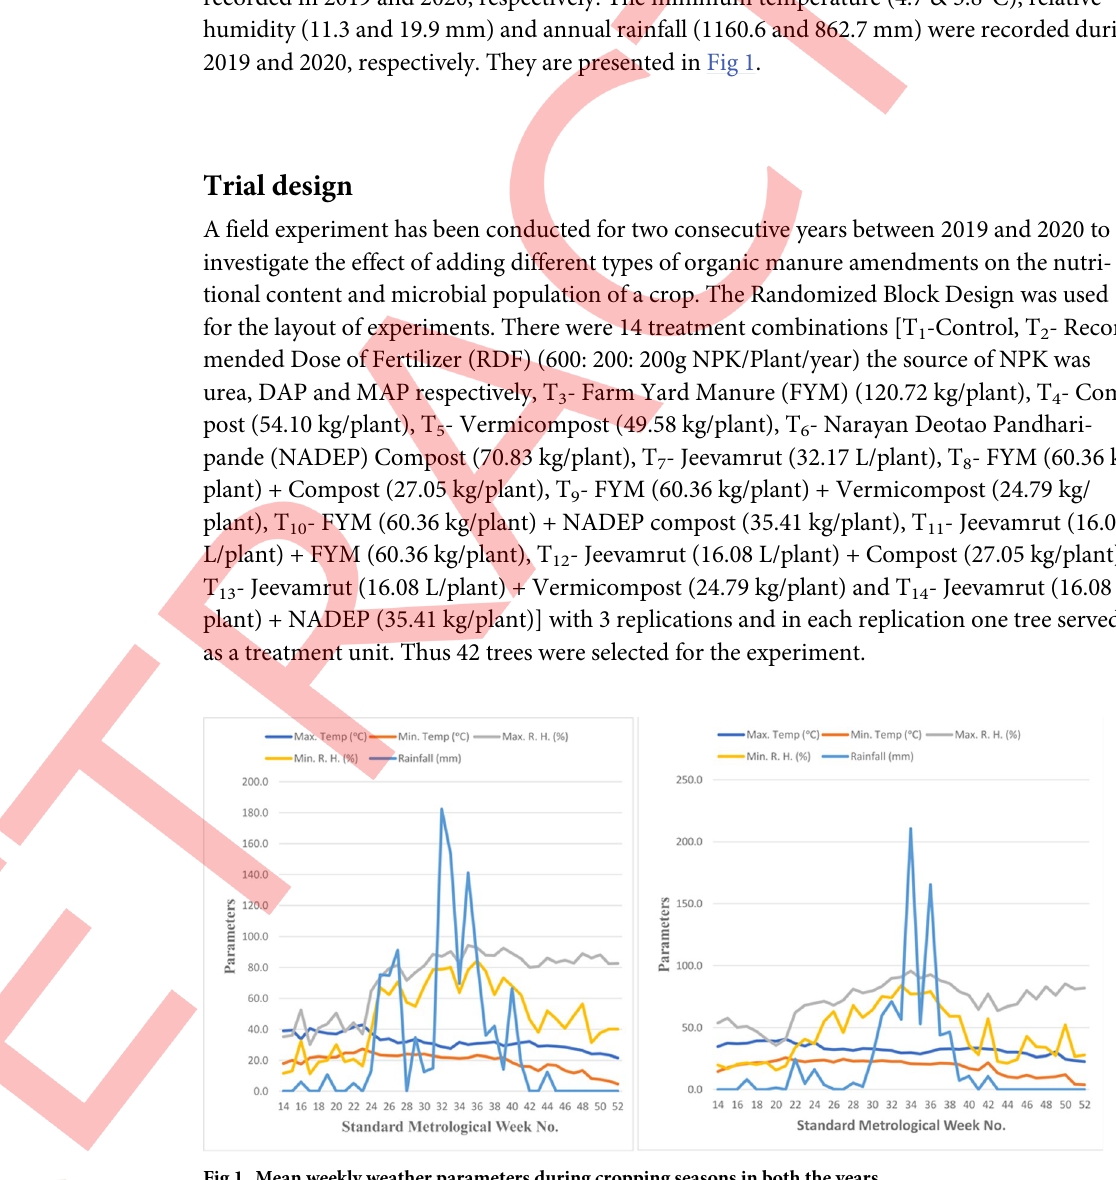
Fig 1. Mean weekly weather parameters during cropping seasons in both the